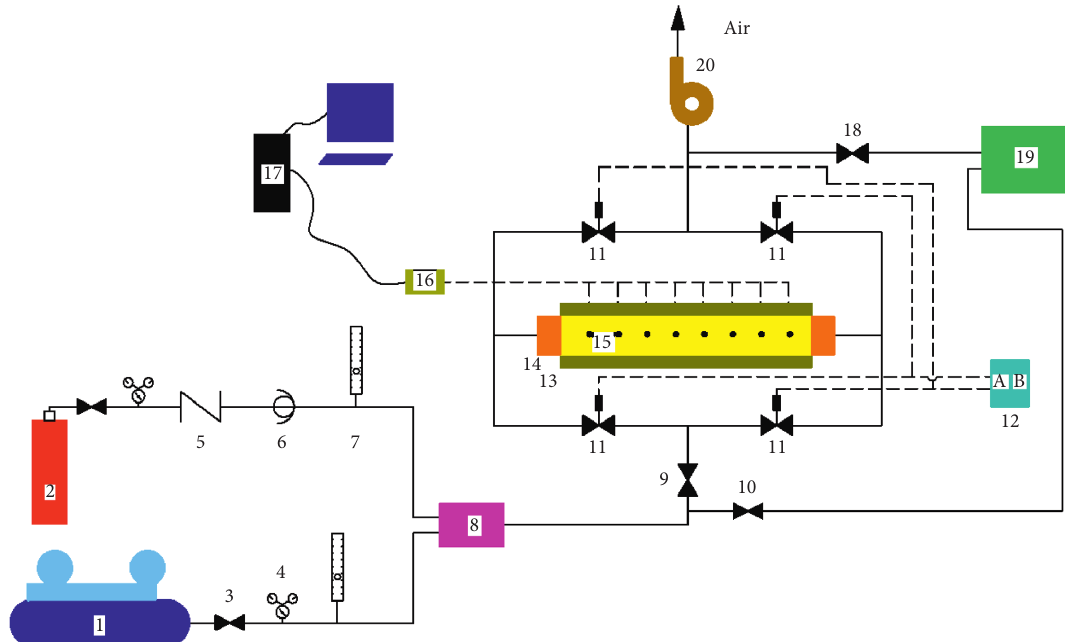
Figure 4: Experimental system for thermal countercurrent oxidation of low-concentration gas in coal mine ventilation (1: air compressor; 2: methane cylinder; 3: regulating valve; 4: pressure reducing valve; 5: one-way valve; 6: flame arrester; 7: rotor flow meter; 8: mixer; 9: intake main valve; 10: intake sampling valve (usually closed); 11: solenoid valve; 12: time relay; 13: device main body; 14: cooler; 15: thermocouple; 16: collection card; 17: computer; 18: exhaust gas sampling valve (usually closed); 19: gas chromatograph; 20: draft